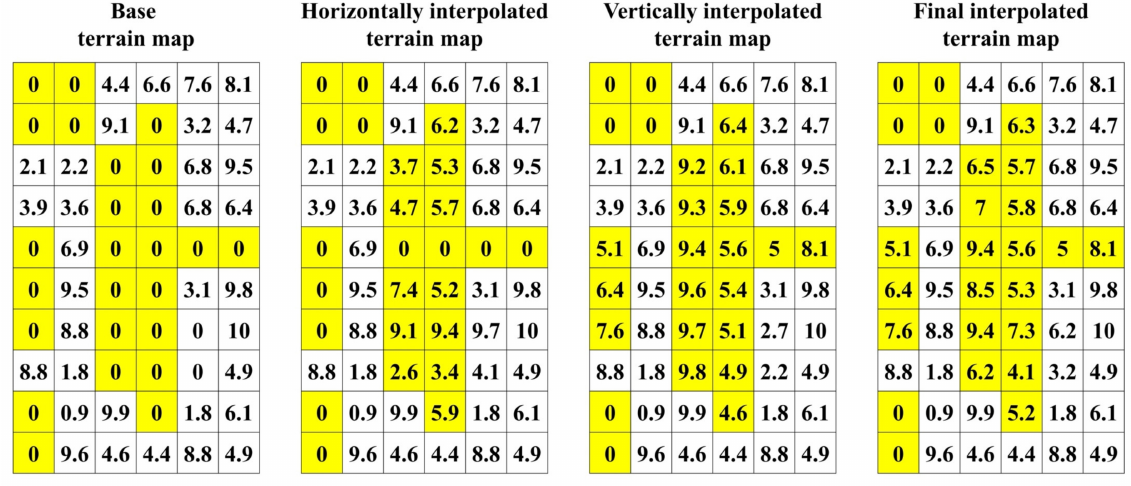
Figure A4. Illustration of the terrain map interpolation process using a randomly generated image. Yellow regions highlight the empty pixels, which can potentially be interpolated.